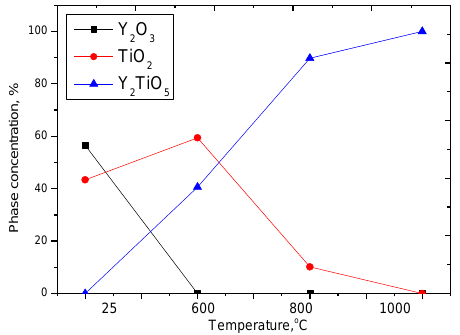
Figure 2. Dynamics of X-ray diffraction patterns of nanostructured ceramics Y 2 O 3 /TiO 2 -Y 2 TiO 5 doped CNTs.